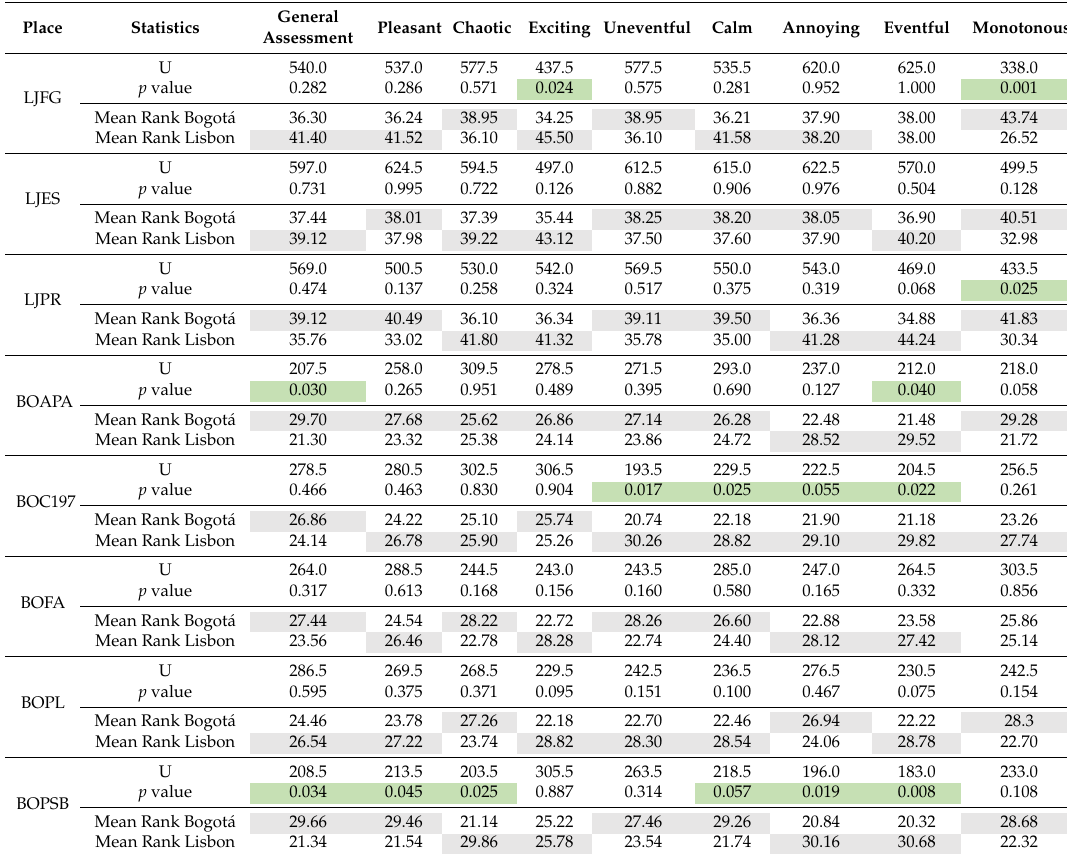
Table 2. Results of the U Mann-Whitney test with α = 0.05 for evaluators from Bogot á and from Lisbon. Green values represent statistically significant differences in the responses according to listener origin. Shaded values represent the highest average rank value between listeners in Bogot á and